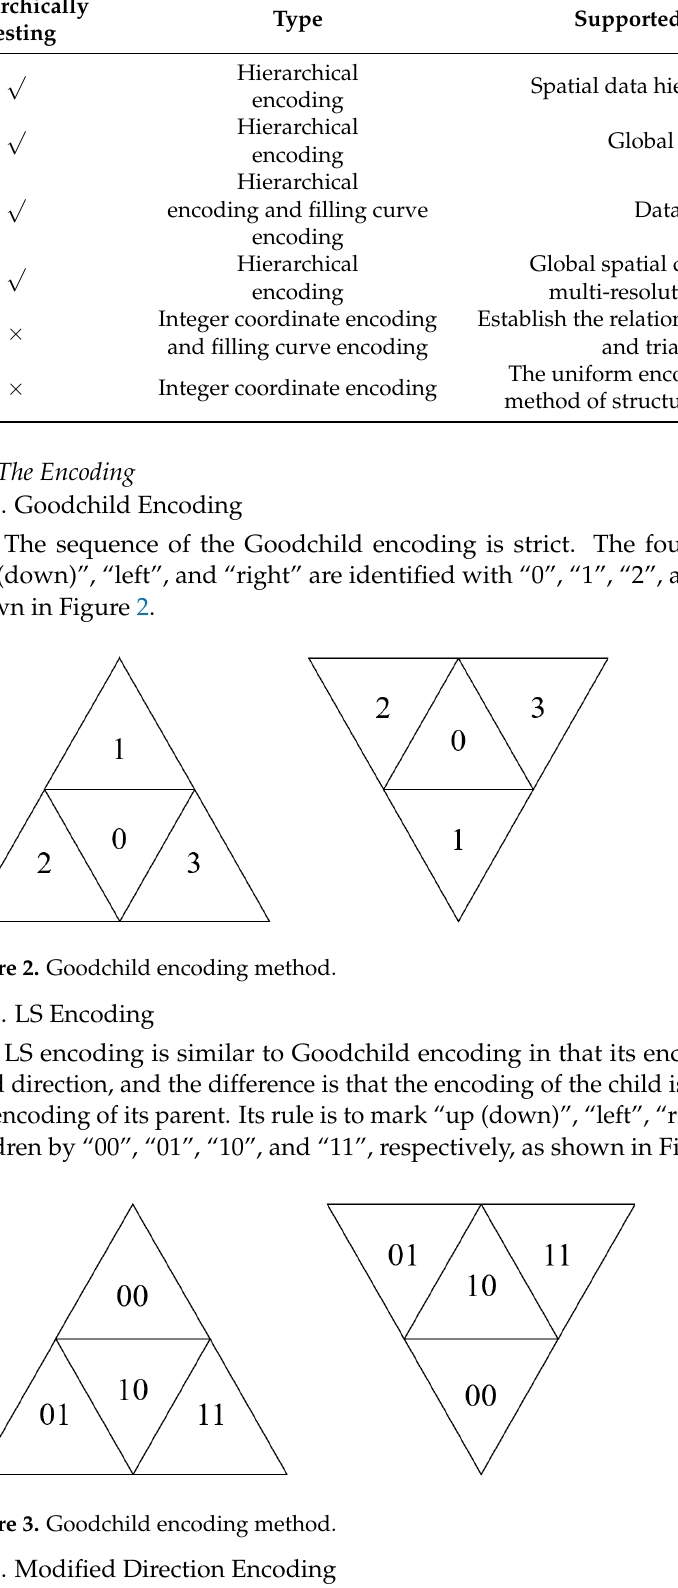
Figure 4. Modified direction encoding method. 2.1.4. Quaternary Encoding Quaternary encoding not only has the characteristics of hierarchy and nesting, but also has the characteristics of continuity, which greatly improves the efficiency of data access, and helps to store the absolute relationship between adjacent spaces. There are 4 situations in which the encodings of 4 children formed by the division of a triangular grid, as shown in Figure 5. Figure 5. Quaternary encoding method. 2.1.5. TRQ Encoding Different from the above-mentioned encoding methods which are based on quad- tree, TRQ encoding is based on linear quadtree rhombic grid encoding. Its method is to